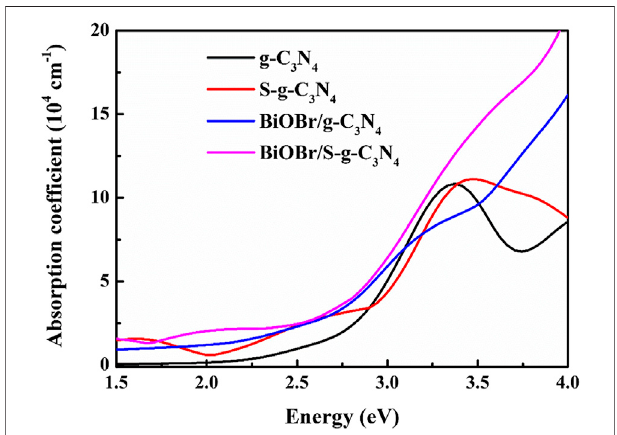
FIGURE 5 | Optical absorption coef fi cients of single layered g-C 3 N 4 , singlelayeredS-g-C 3 N 4 ,BiOBr/g-C 3 N 4 ,andBiOBr/S-g-C 3 N 4